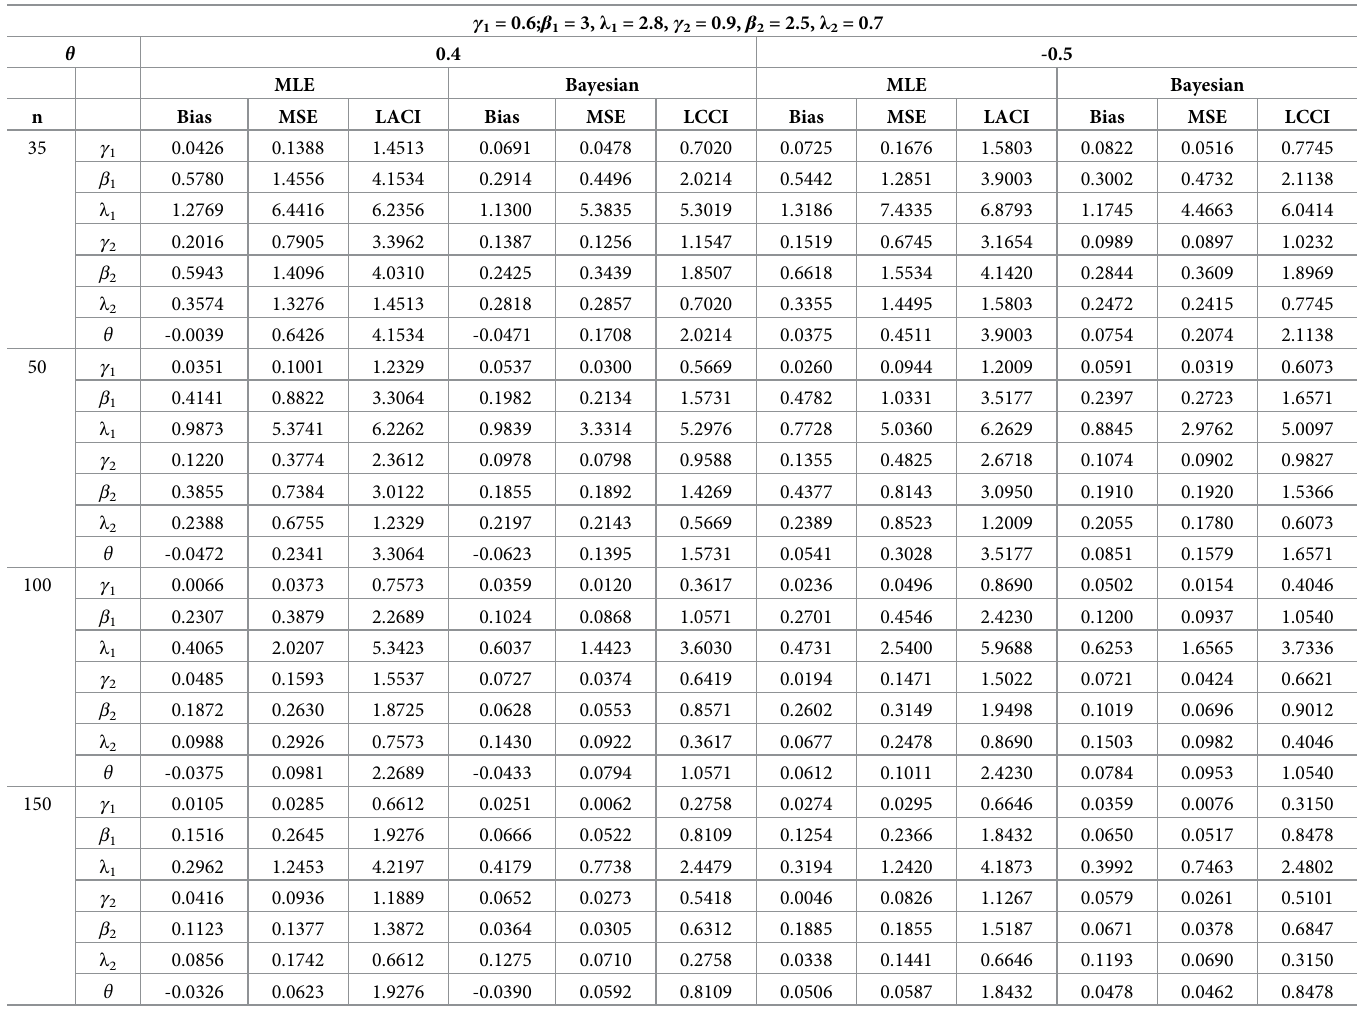
Table 1. MLE and Bayesian estimation method for BFGMPLx model